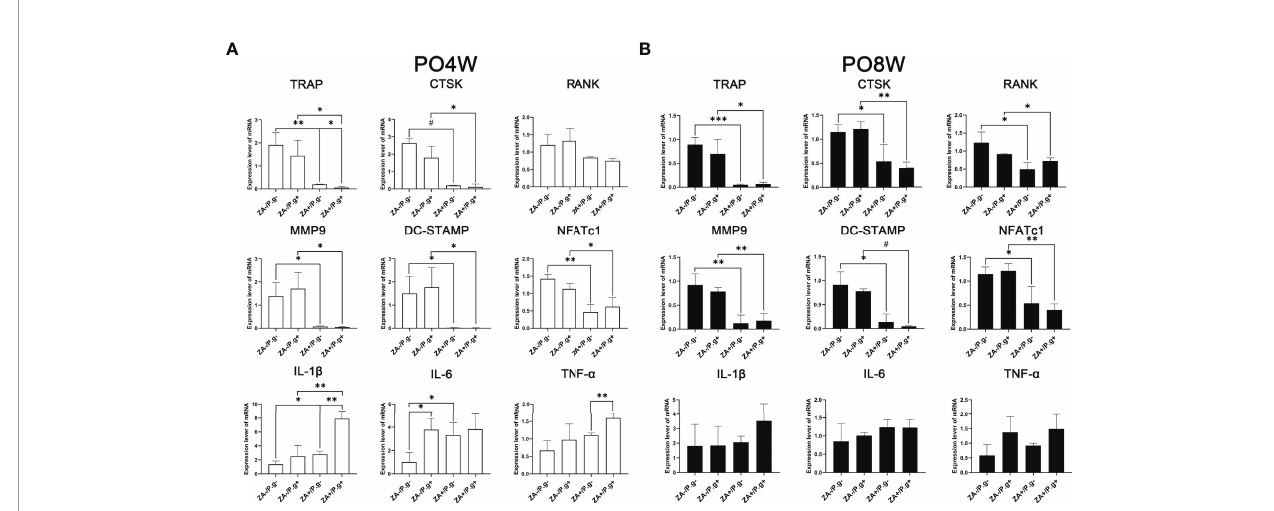
FIGURE 5 | ZA administration and P. gingivalis infection altered the expression level of osteoclastogenesis- and in fl ammation-related genes. (A) PCR results of 4 weeks postoperatively. The expression level of osteoclastogenesis-related genes (TRAP, CTSK, MMP9, DC-Stamp and NFATc1) were signi fi cantly